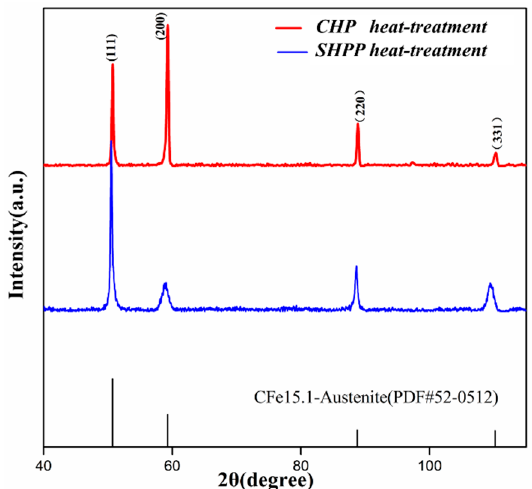
Figure 7. Phase analysis by X-ray diffraction (XRD) pattern of CHP steel (red curve) and SHPP steel (blue curve).